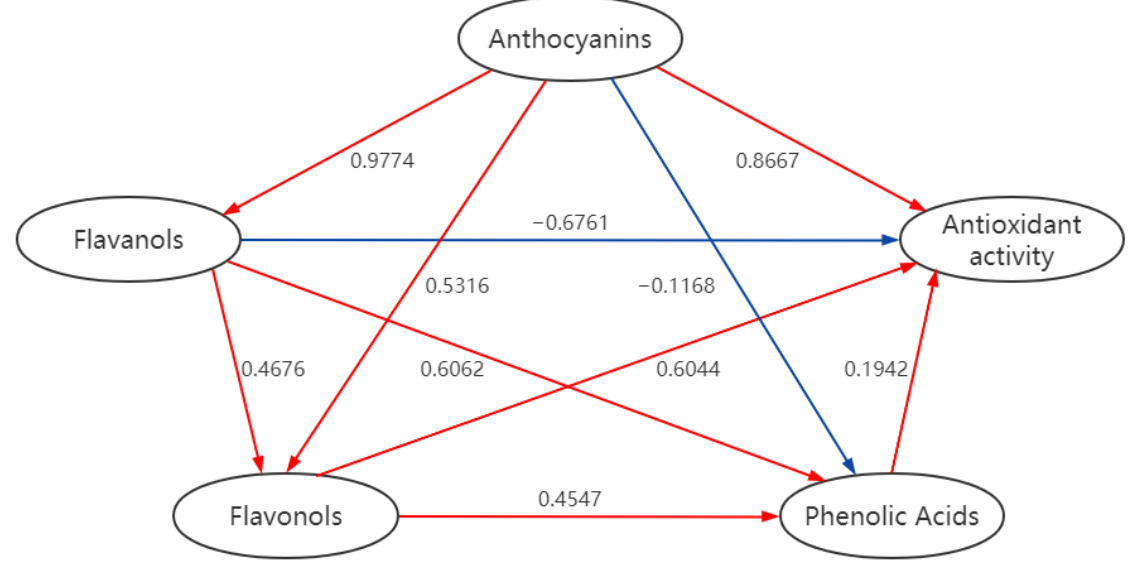
Figure 2. Partial least square structural equation mode.